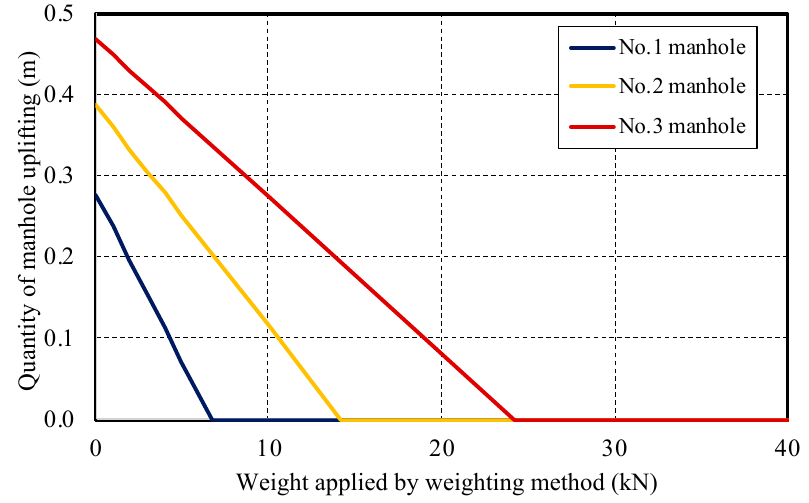
Figure 8. ∆𝑓 for circular manholes Nos. 1, 2, and 3.